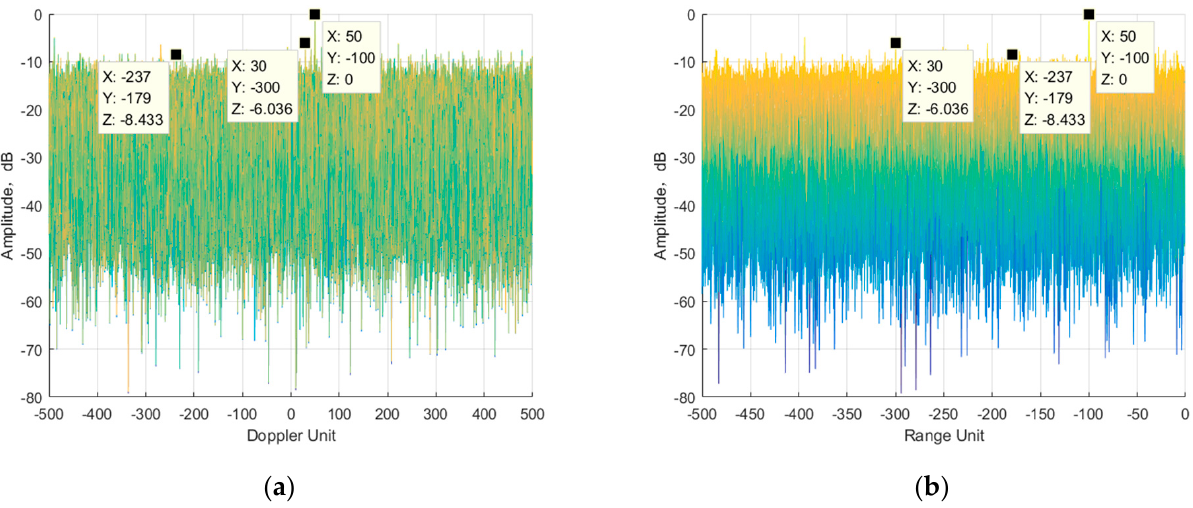
= × ; ( a ) Doppler dimension; ( b )